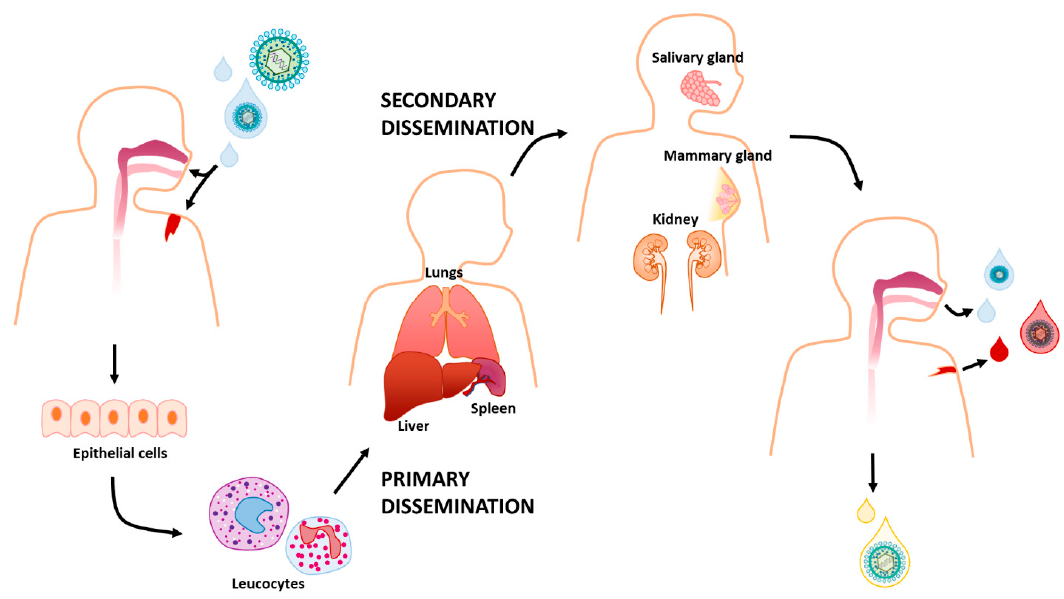
Figure 3. HCMV can be transmitted directly from person to person through bodily fluids including saliva, urine, cervical, and vaginal secretions, breast milk, semen, blood, and tears. It infects a new host usually by getting in through the upper gastrointestinal gastrointestinal tract or the respiratory tract. Here, the epithelial cells are often the first site of infection and from there HCMV infects leucocytes that traffic around the body. This is correlated with a process called primary viral dissemination that leads to the infection of multiple tissues, such as lungs, liver, and spleen. Afterwards, secondary viral dissemination spreads the infection to secretion-producing organs, such as salivary and mammary glands and kidneys, which shed the virus.